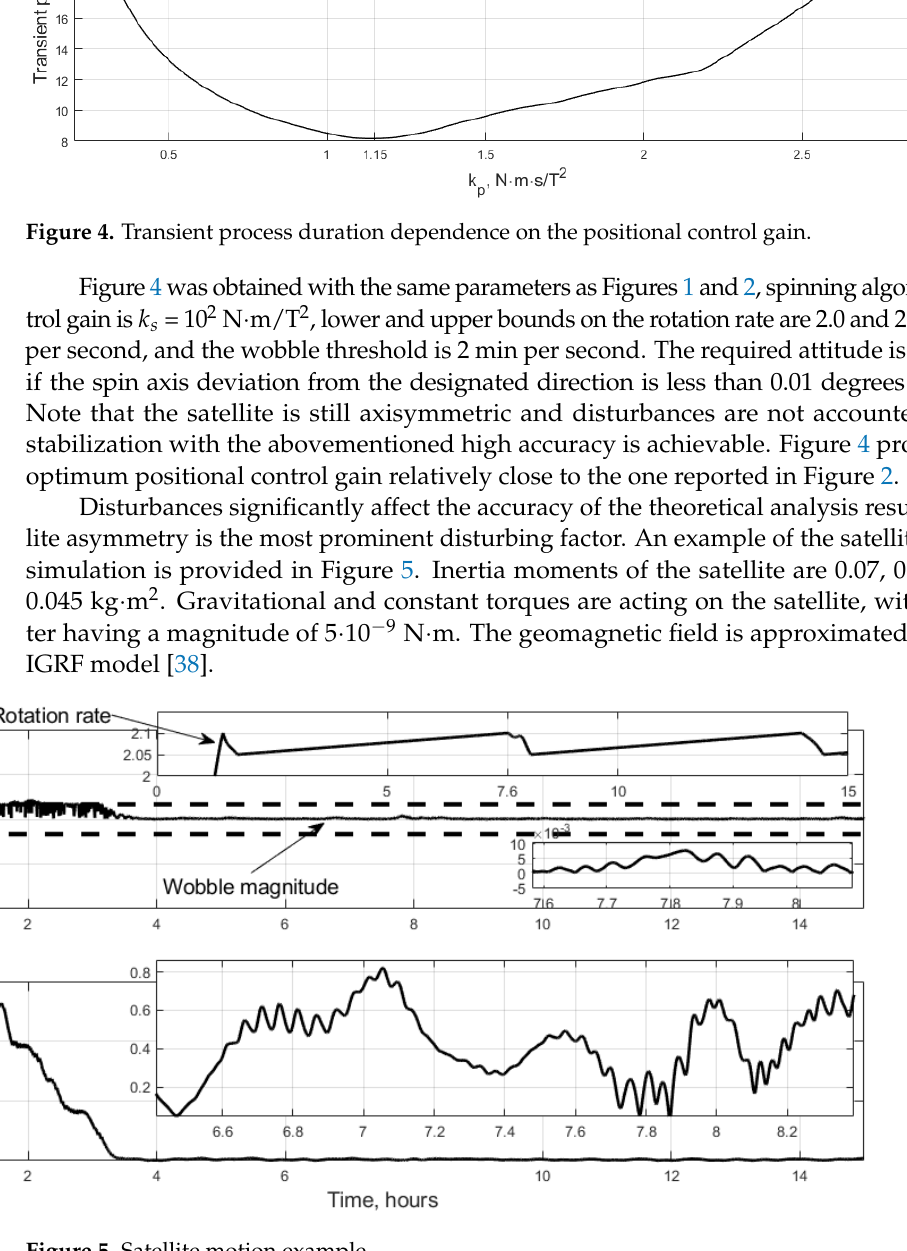
Figure 5. Satellite motion example.